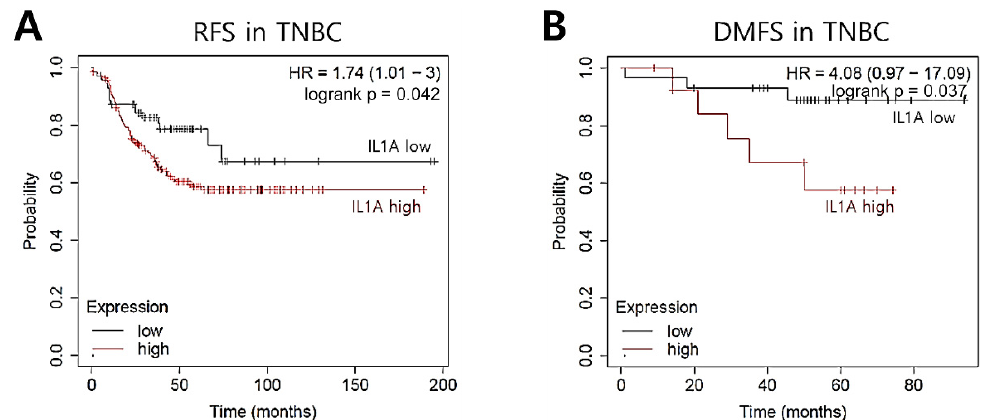
Figure 3. IL1A induction is related to recurrence rates in TNBC patients. The clinical significance of IL1A expression in TNBC patients was analyzed through the KM plotter database. ( A ) RFS, ( B ) DMFS.